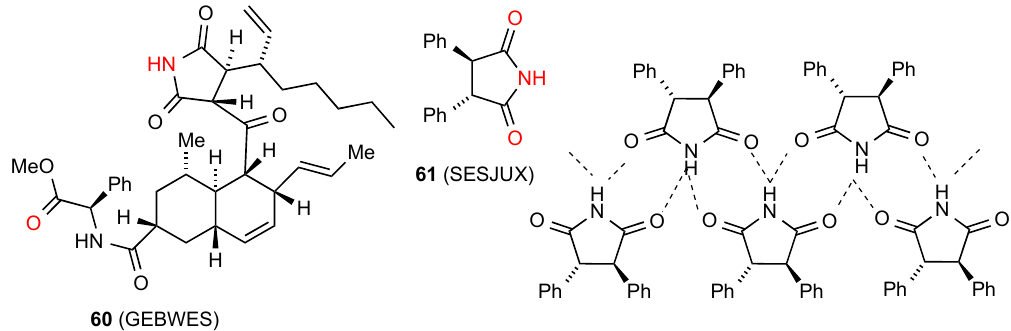
Figure 21. Structures of other 3,4-disubstituted succinimides.